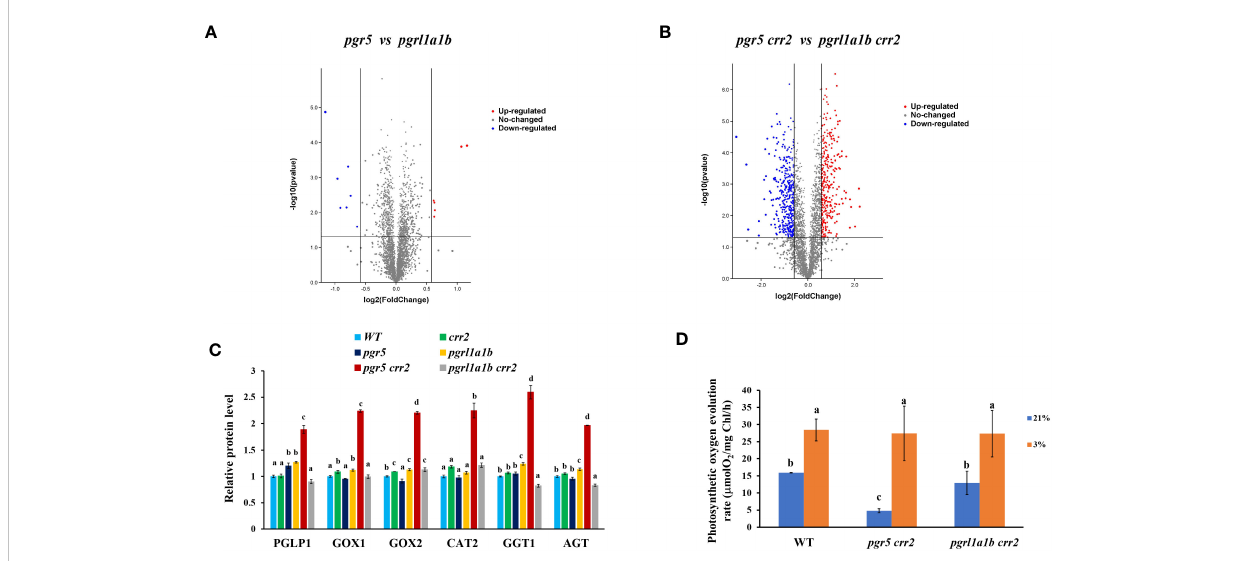
FIGURE 5 Proteome differences and photosynthetic oxygen evolution between pgr5 crr2 and pgrl1a1b crr 2 grown under high light conditions. (A) Volcano maps of differentially chloroplast-associated proteins in pgr5 vs. pgrl1a1b ; there were 7 downregulated proteins and approximately 6 upregulated proteins. (B) Volcano maps of proteins in biological differences in pgr5 crr2 vs. pgrl1a1b crr2 ; there were 400 downregulated proteins and approximately 326 upregulated proteins. Red and green spots represent differentially expressed proteins; red spots represent upregulated proteins, and blue spots represent downregulated proteins. (C) Comparison of key proteins involved in the photorespiratory pathway and photosynthetic oxygen evolution rate among the CET mutants and wild type (WT). The level of key proteins involved in photorespiration. PGLP1, phosphoglycolate phosphatase 1; GOX1, glycolate oxidase 1; GOX2, glycolate oxidase 2; CAT2, peroxisomal catalase 2; GGT1, glutamate – glyoxylate aminotransferase; AGT, alanine – glyoxylate aminotransferase. There is a signi fi cant difference ( p < 0.05) labeled with different letters on the column. The least difference method ( LSD method) was used for the difference signi fi cance test and multiple ratio comparison. (D) The photosynthetic oxygen evolution rates in CET mutants and WT are under 3% or 21% O 2 . Plants for analysis were cultured on agar plates at 60 m mol m − 2 s − 1 at 22°C for 10 days and then transferred to soil with a 16/8-h light/dark cycle and a photosynthetic photon fl ux density of 120 m mol m − 2 s − 1 at 22°C for 18 days. Values are means ± SE (n = 5 – 9) of four independent